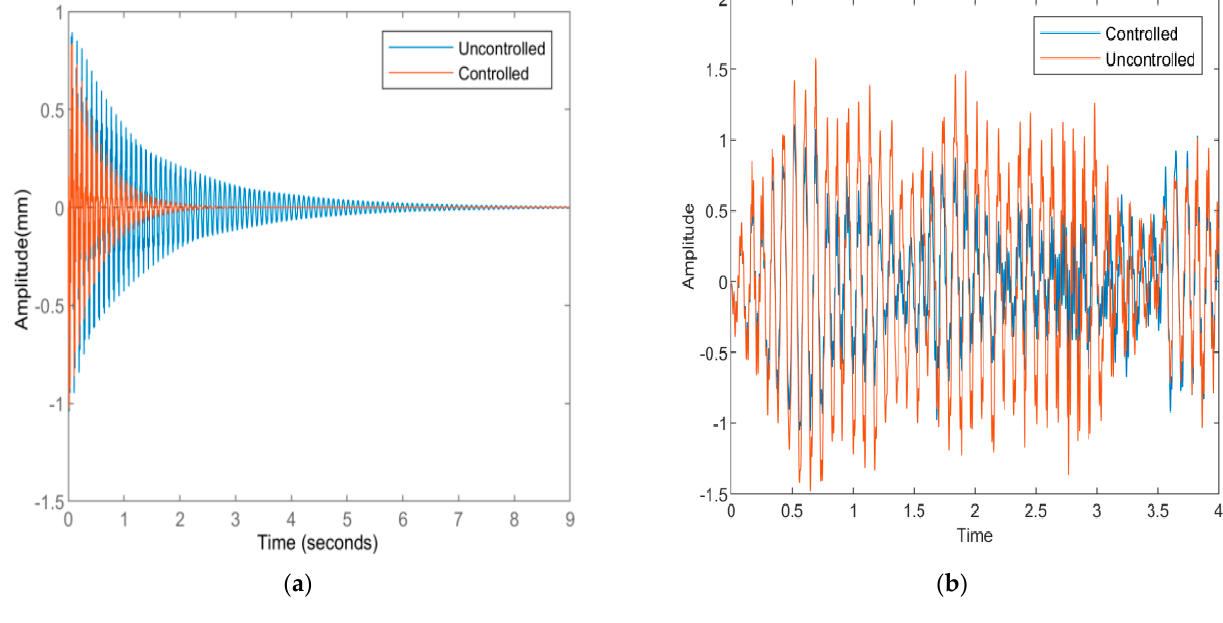
( d ) Figure 13. Response diagram before and after system control. ( a ) Response of CFFF plate under pulse excitation; ( b ) CFFF plate response under white noise; ( c ) response of CFCF plate under pulse excitation; ( d ) CFCF plate response under white noise.